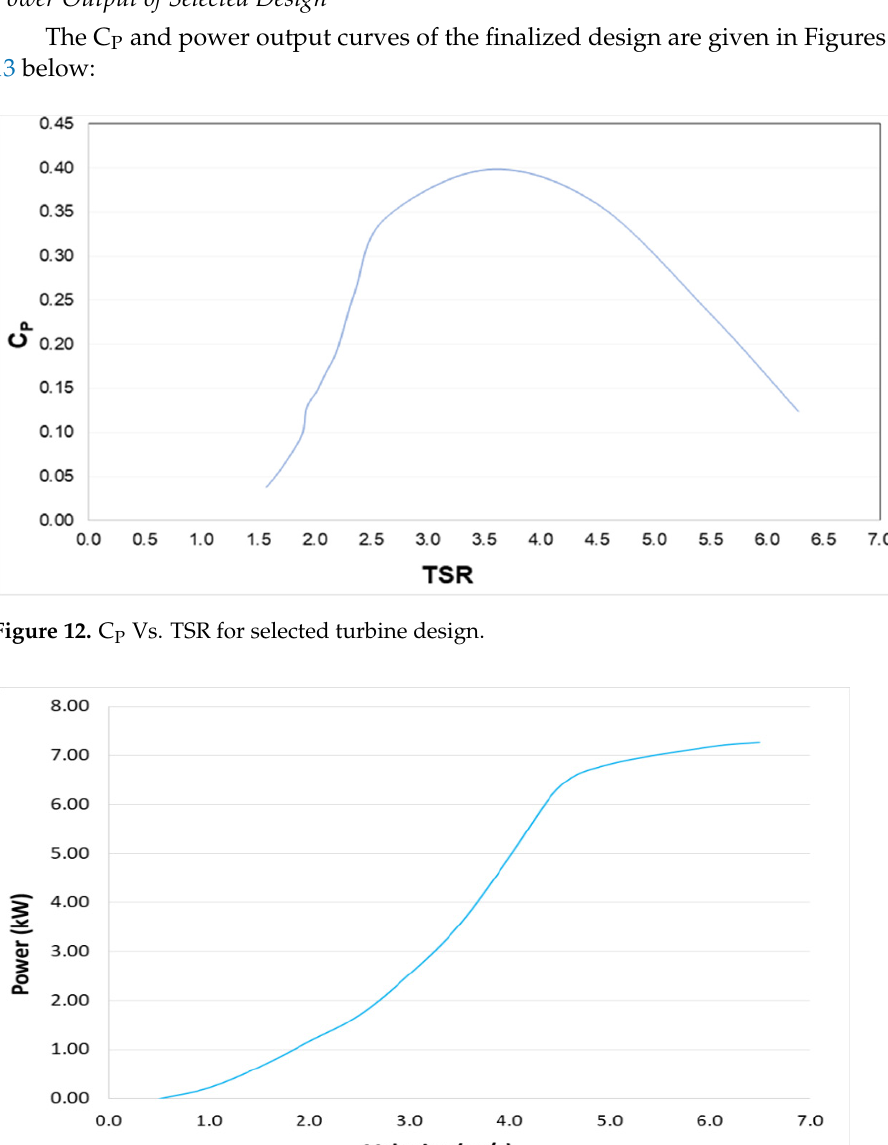
Figure 12. Power output vs. velocity for selected turbine design. Figure 13. Power output vs. velocity for selected turbine